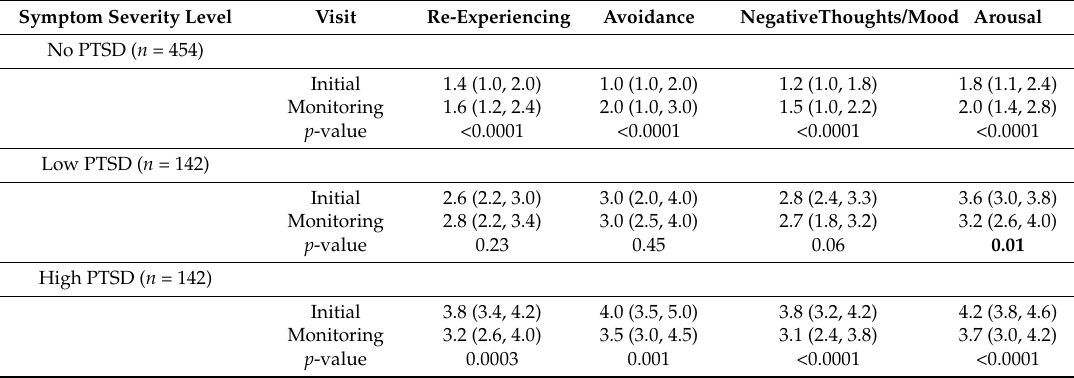
Table 4. PCL cluster scores at Initial and Monitoring visit in PTSD severity